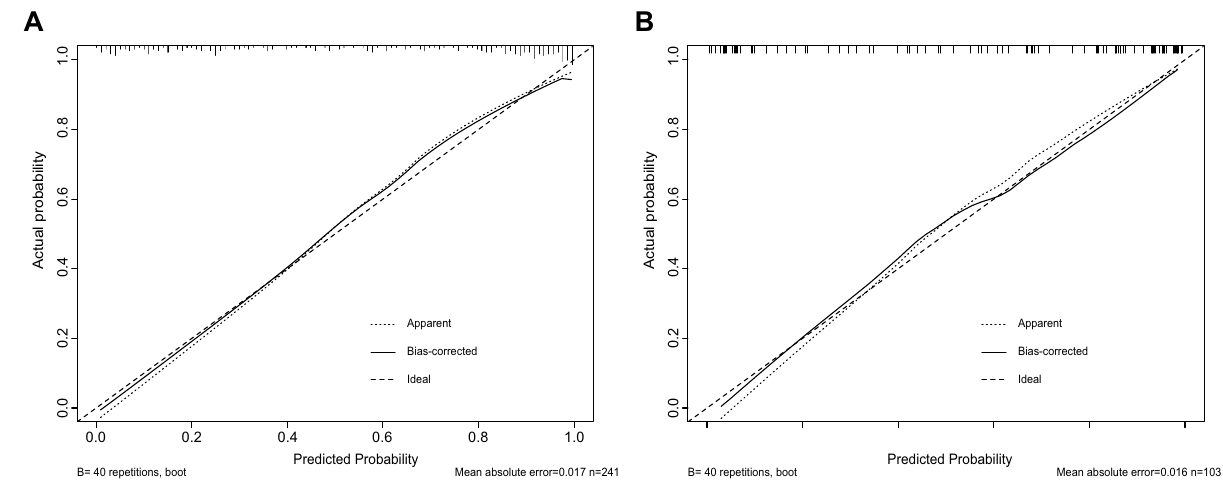
Figure 3. Calibration curve of the discrimination nomogram in the (A) training group or (B) test group. The x-axis represents the predicted probability of MN. The y-axis represents the actual pathologically diagnosed MN. The diagonal dotted line represents a perfect prediction by an ideal model. The solid line represents the performance of the nomogram, of which a closer fit to the diagonal dotted line represents a better prediction.